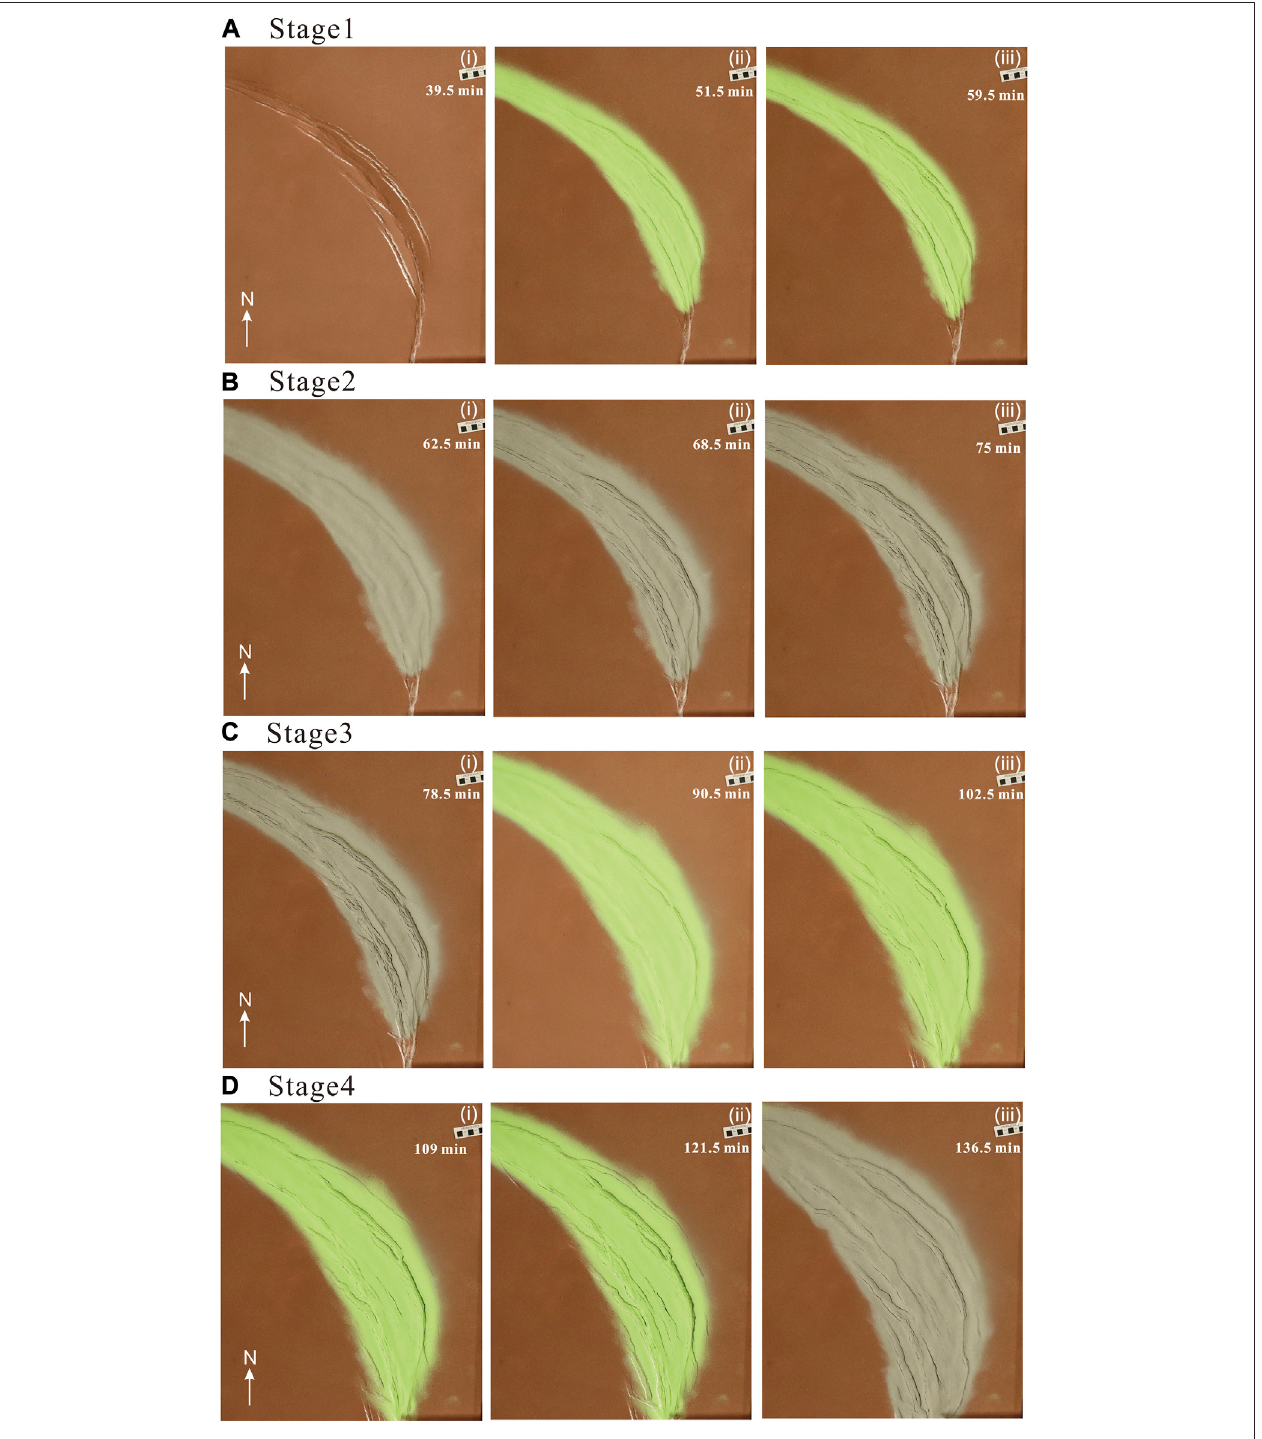
FIGURE 5 | Evolution of deformation with stages 1 (A) , 2 (B) , 3 (C) , and 4 (D) . The four panels in (A – D) represent a primitive image without interpreted fault lines.